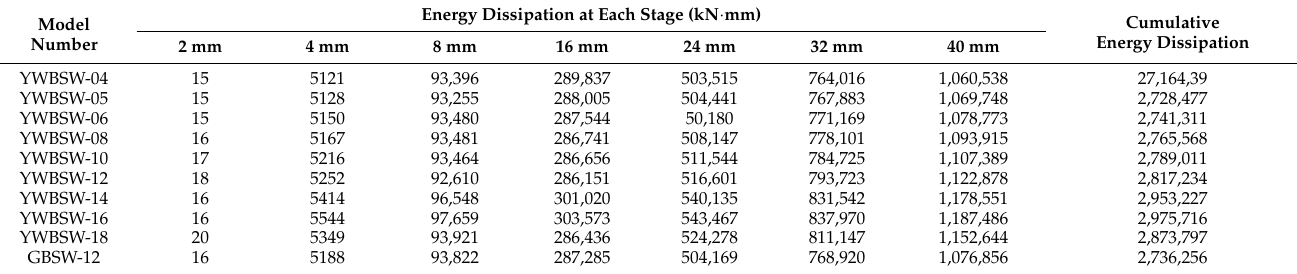
Table 7. Energy dissipation at all levels for models with different fishplate thicknesses.